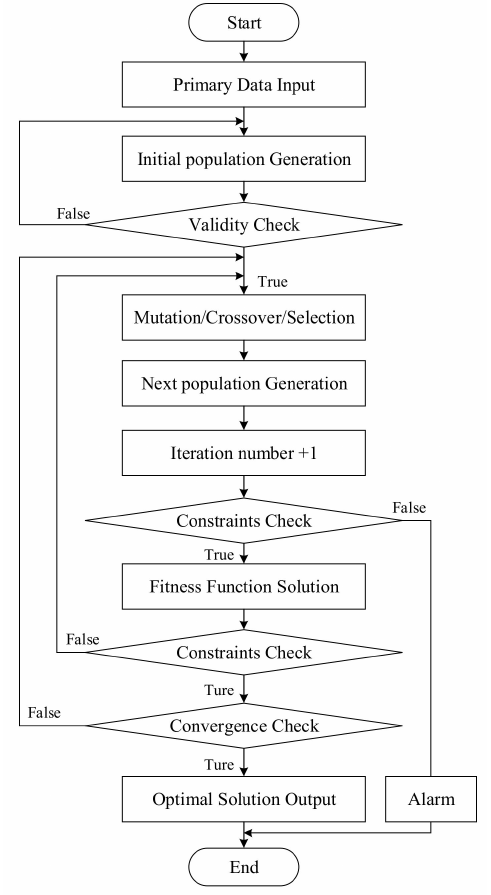
Figure 4. Flow chart of multi-objective function